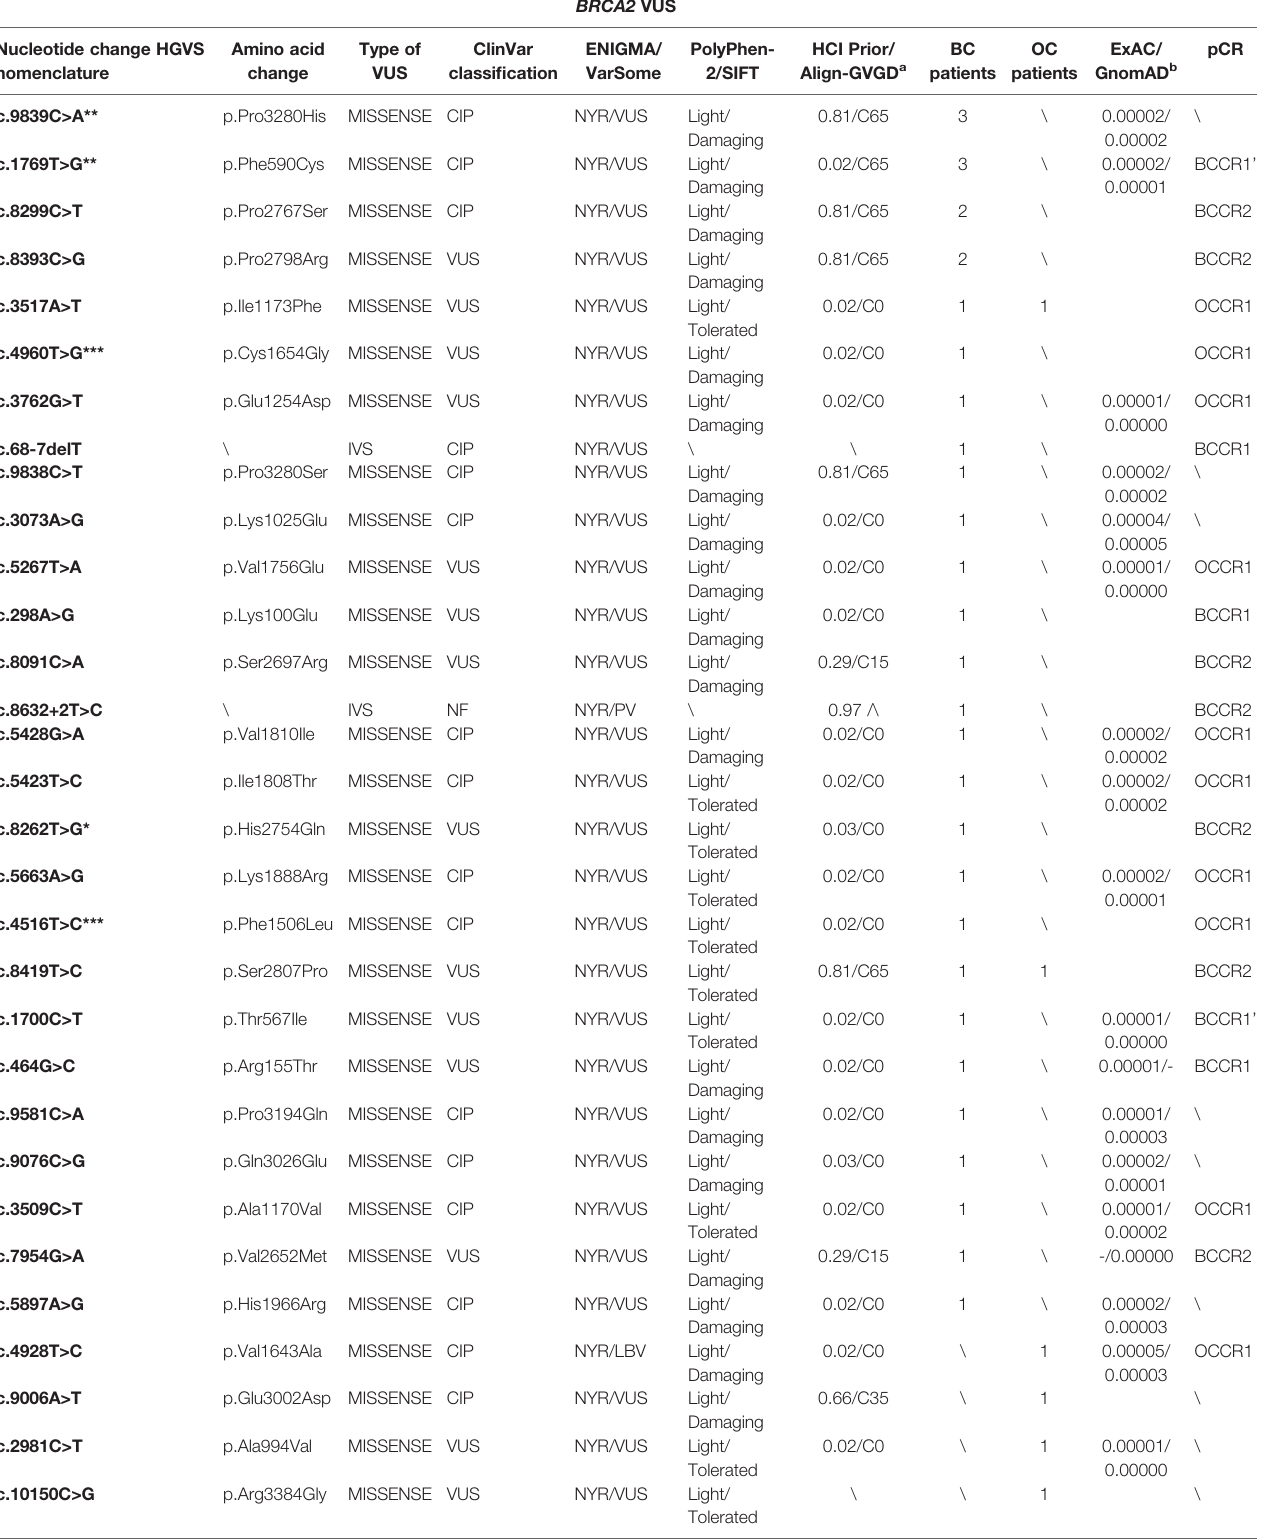
TABLE 3 | BRCA2 gene variants of unclear signi fi cance harbored by patients with breast and ovarian